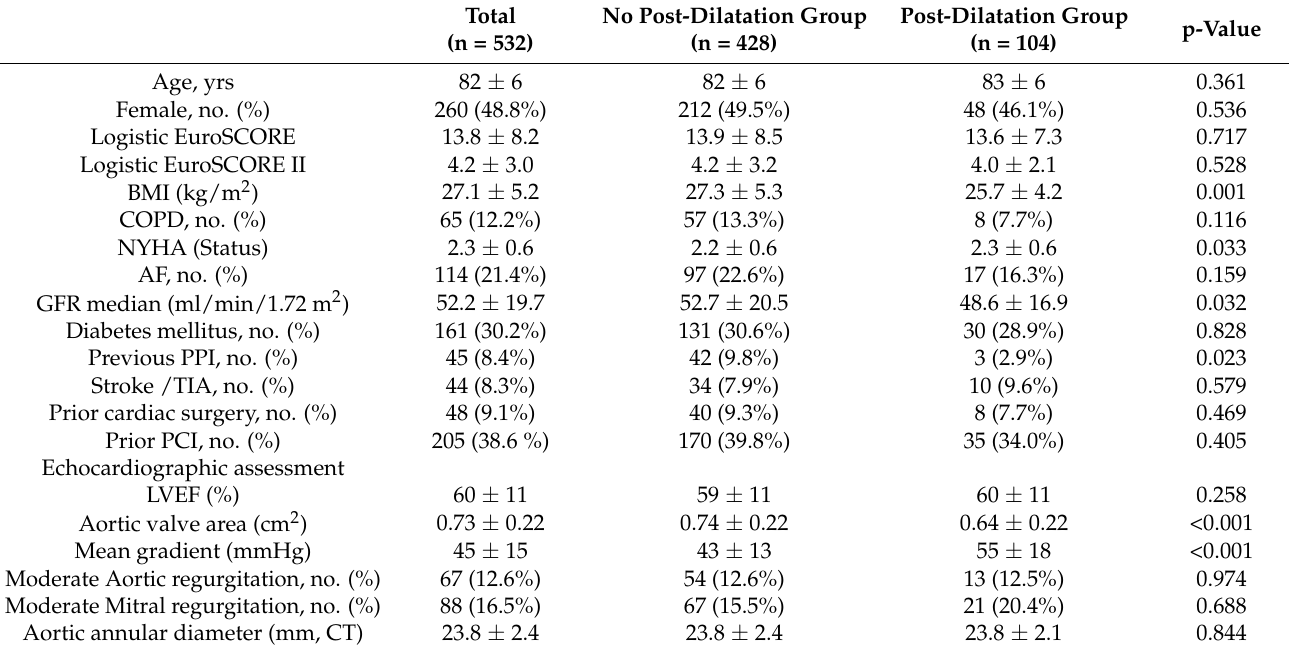
Table 1. Baseline